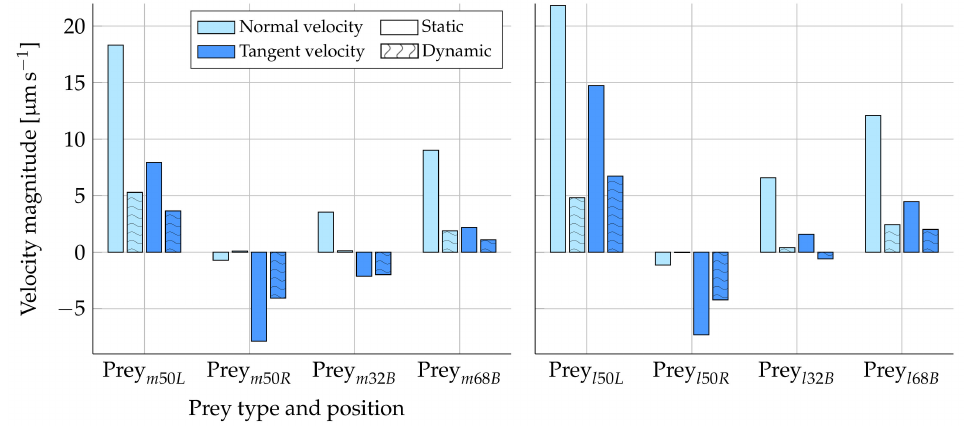
Figure 8. Prey velocity components in the normal and tangent directions to the collar from both the static and dynamic analyses. A prey was placed on the middle and left-hand side of the collar (50 L ), the middle and right-hand side (50 R ), the top and back side (32 B ), and the bottom and back side (68 B ). The left plot shows the results for a medium-sized prey, and the right plot shows the results for a large-sized prey. All results were simulated with the presence of the lorica and at the flagellum position pictured in Figure